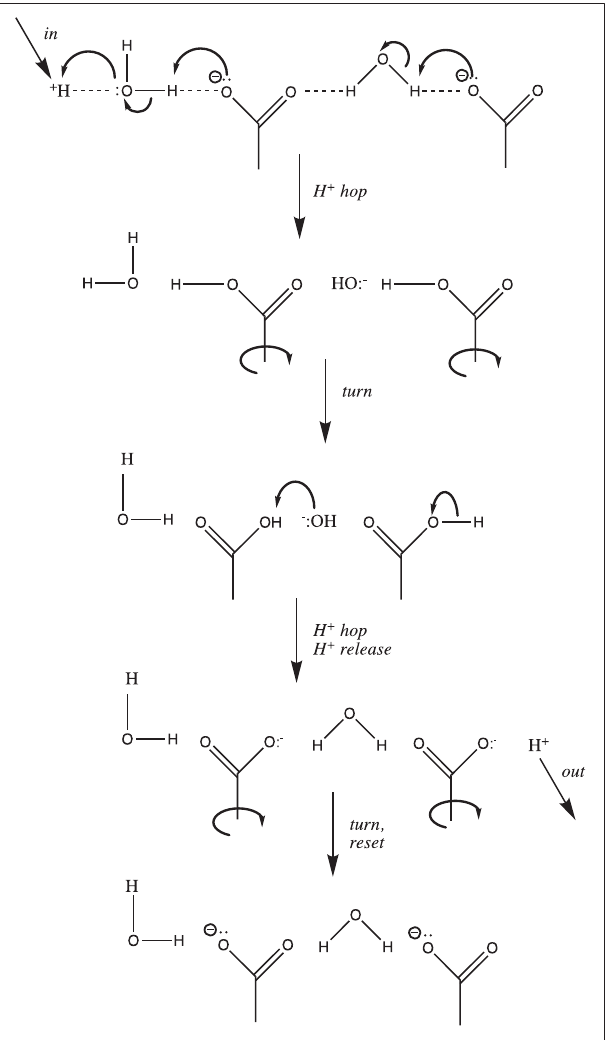
FIGURE 4 | Simple proton wire comprising two water molecules and two carboxylate side